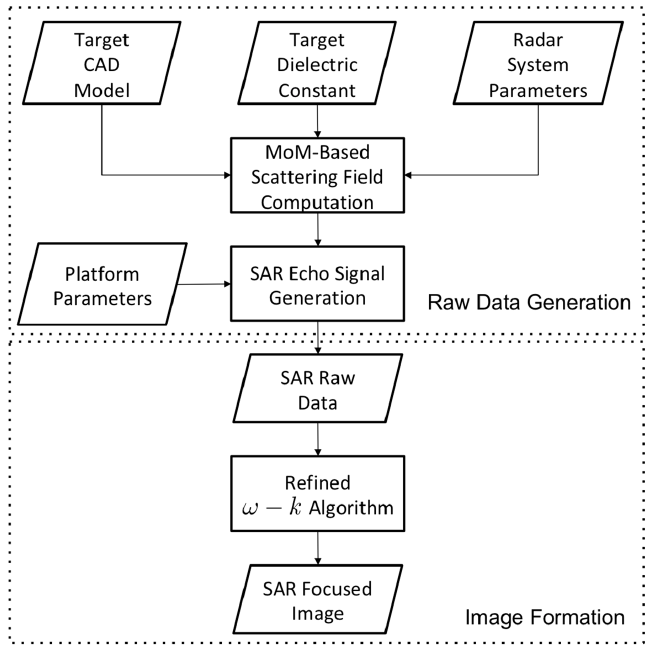
Figure 3. Full-wave based SAR image simulation flowcharts.